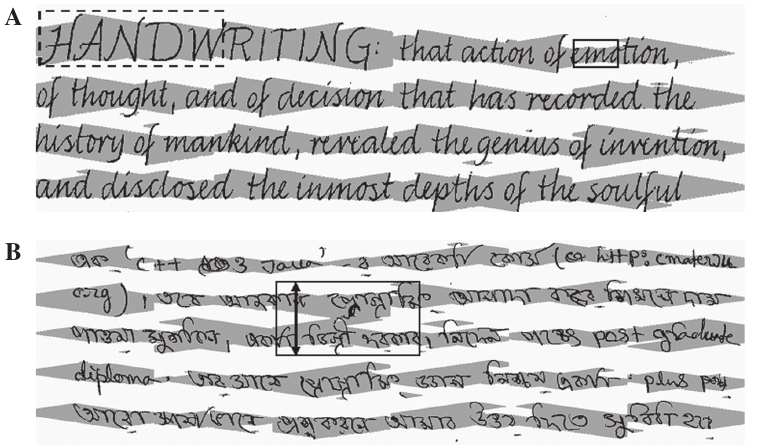
Figure 5. Huge Variations in Text Line Heights May Be Observed After the Water Flow Technique Is Used in the Whole Document. (A) The Small Rectangle Indicates Lesser Text Line Height (Especially at the Start/End of Flow Regions). (B) The Big Rectangle Indicates Larger Text Line